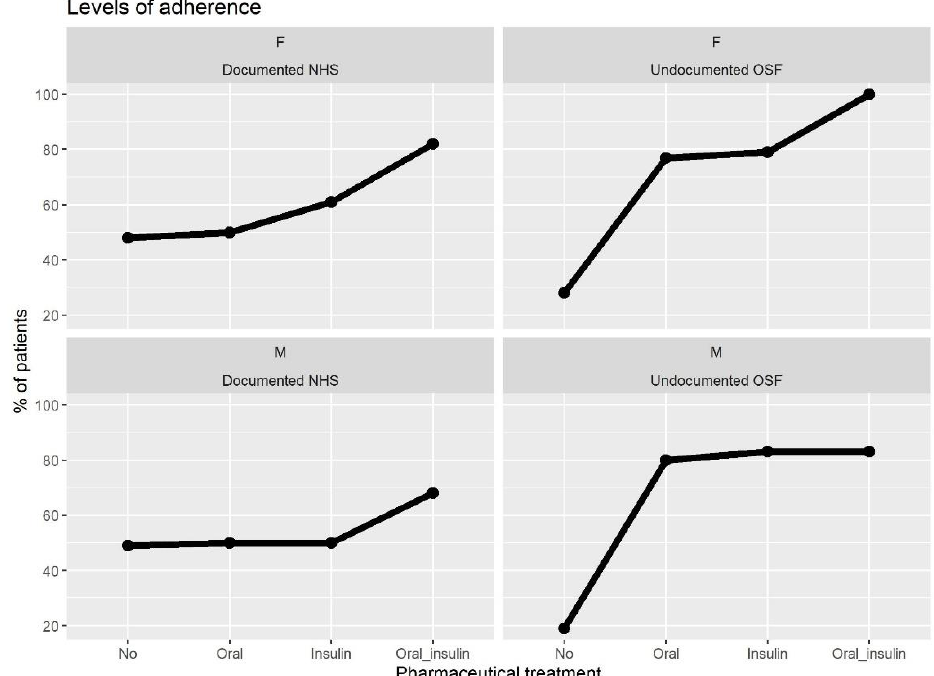
Figure 2. Adherence by sex and therapy, divided for the groups Undocumented OSF and Docu- mented NHS.